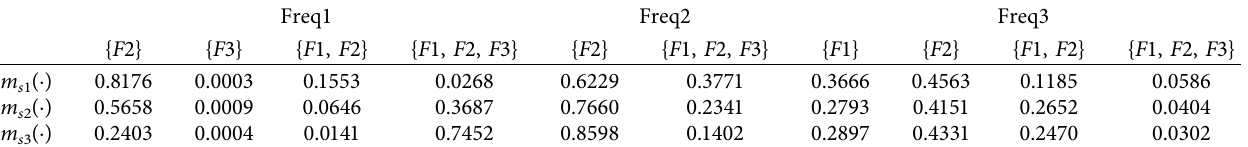
Table 4: Data for fault diagnosis modeled as BPAs.